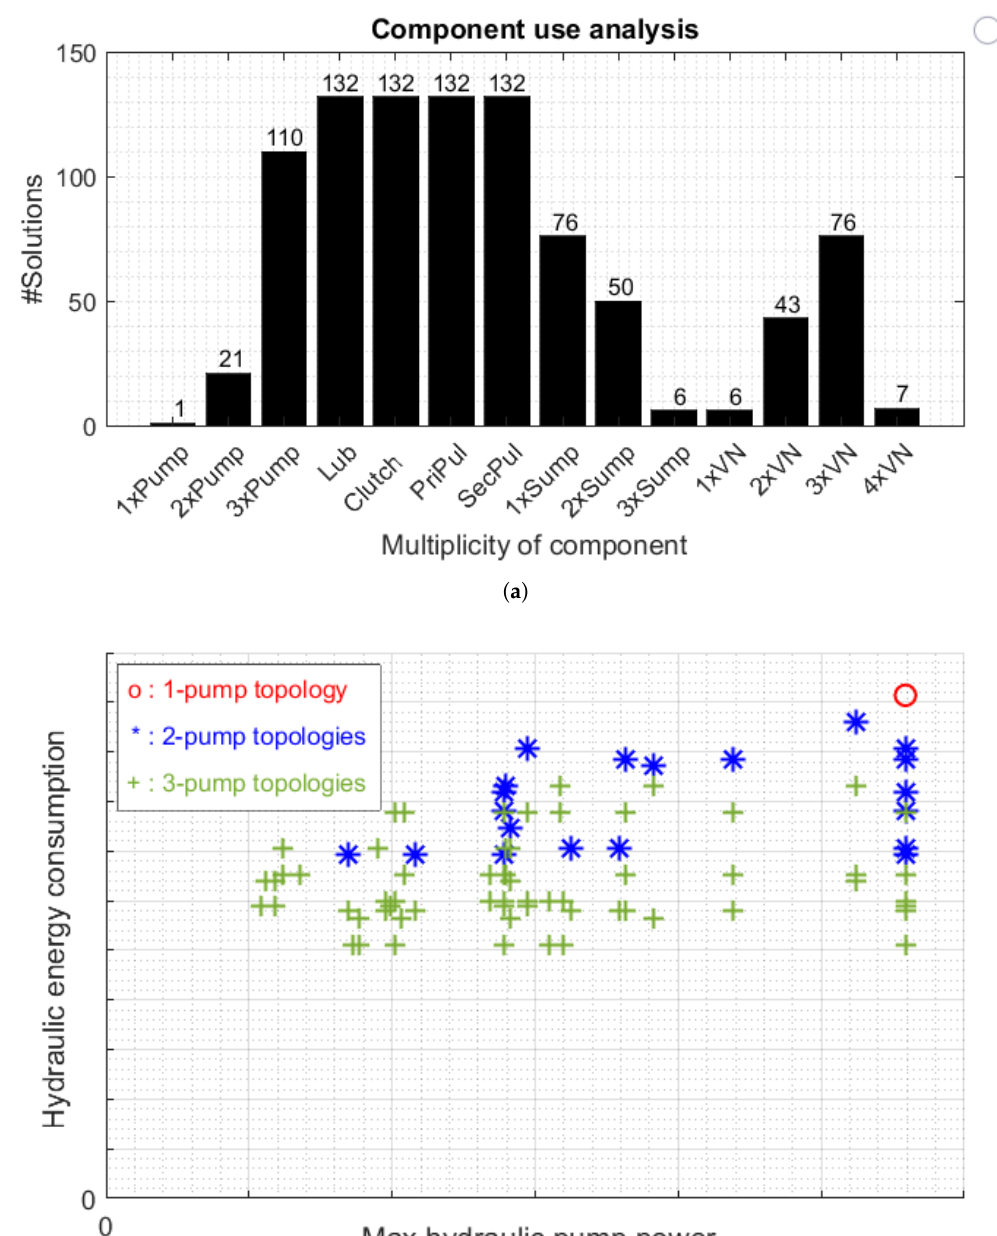
Figure 12. Topology generation and performance results. For reasons of confidentiality, the absolute power values are not depicted. ( a ) Histogram of the generated feasible topologies for the electro-hydraulic actuation system. ( b ) Diagram showing the average and maximum actuation power of novel and newly synthesized on-demand CVT actuation systems simulated using the Worldwide Harmonized Light Vehicle Test Procedure (WLTP) for a passenger